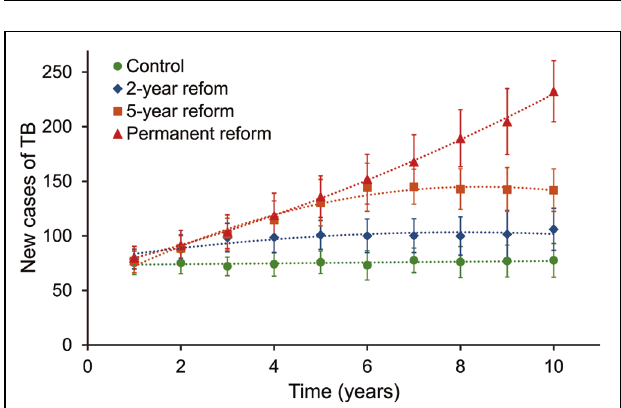
FIGURE 3 | Results of the calibration process (see Table 2 in text). Four relevant output of 30 runs with the calibrated dataset are shown in four boxplots: (A) accumulated sick people, (B) percentage of sick with diabetes, (C) percentage of sick with TB/HIV coinfection, and (D) percentage of sick with other risk factors. Dotted lines plot the data from the literature (Orcau i Palau et al., 2015).